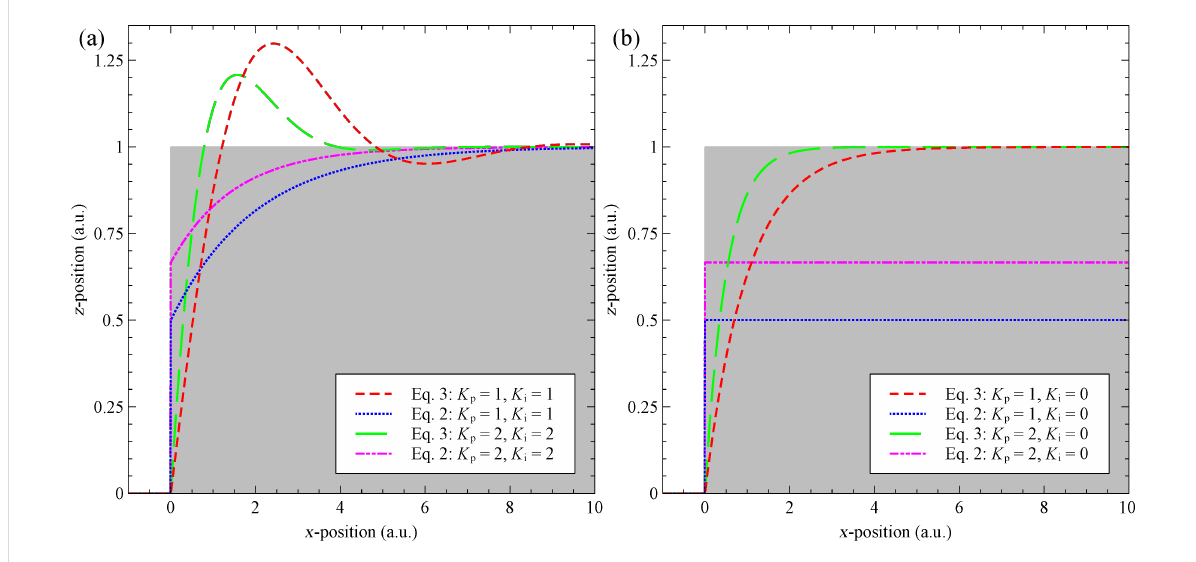
Figure 2: Direct comparison of our model (Equation 3, red and green lines) with the model from the current literature (Equation 2, blue and pink lines), without modelling of electrical or mechanical components. The comparison is performed for a full PI controller (a) and a simple proportional controller (b), where the grey area represents the surface being tracked with a set-point of 0. Equation 2 shows unexpected discontinuities and does not tract the set-point for a proportional controller. Instead it only reacts to the initial impulse. Equation 3 produces the expected results from elementary control theory. All gain units are